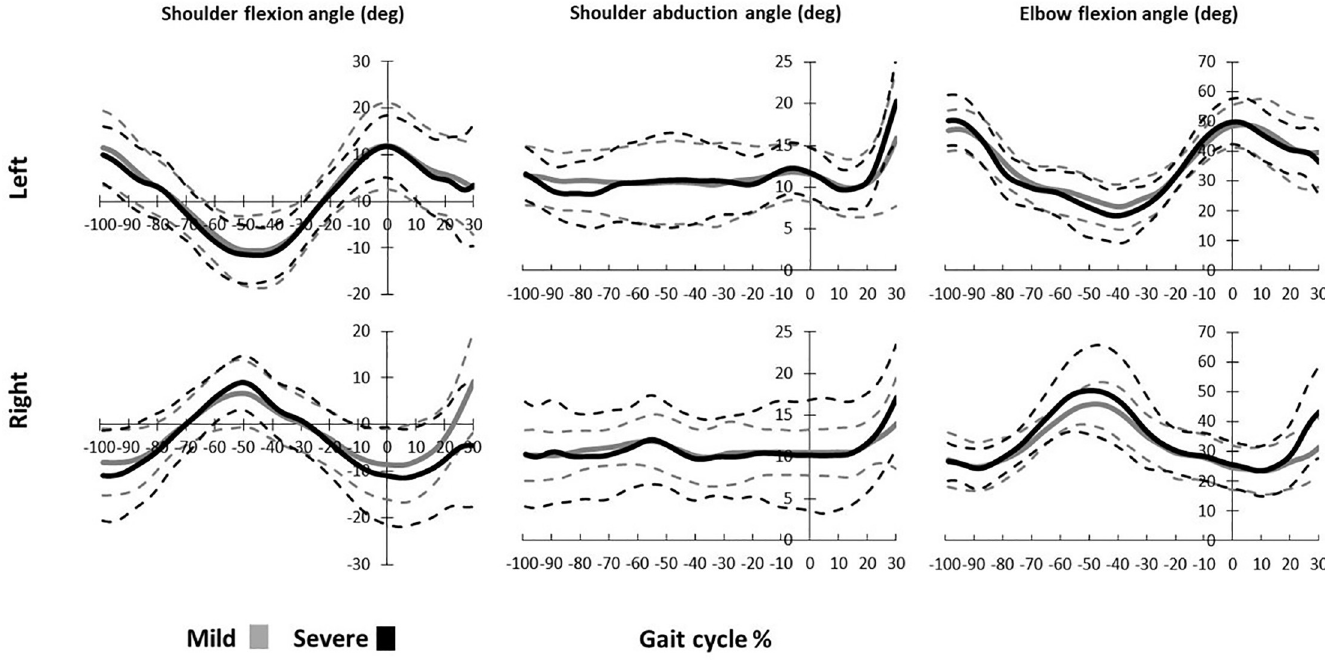
Fig 2. Upper body kinematics for mild and severe slippers for a full gait cycle prior to slip (-100% to 0%) and 30% of the gait cycle time length during slipping. The bold lines represent the average values while the dashed lines indicate the standard deviation.